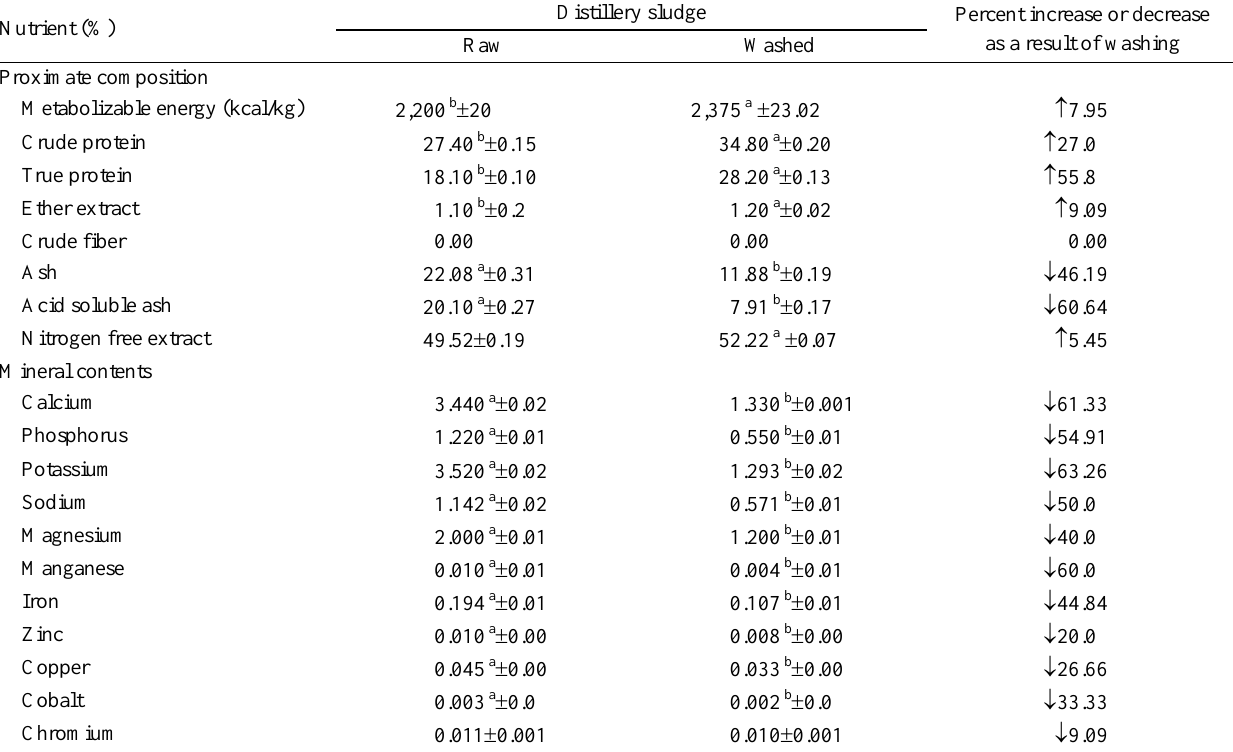
Distillery sludge Percent increase or decrease